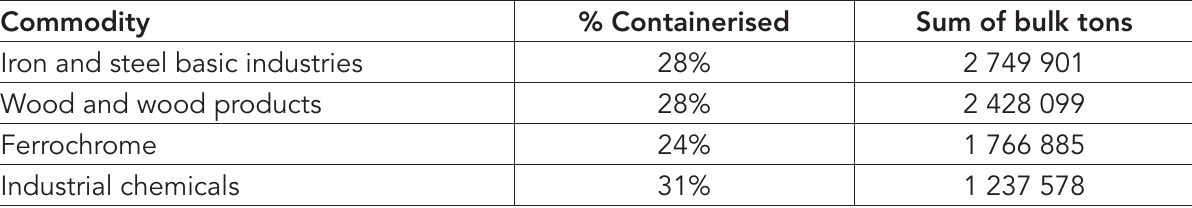
Table 2: Commodity groups, percentage containerised and bulk tons for exports (2009) Commodity